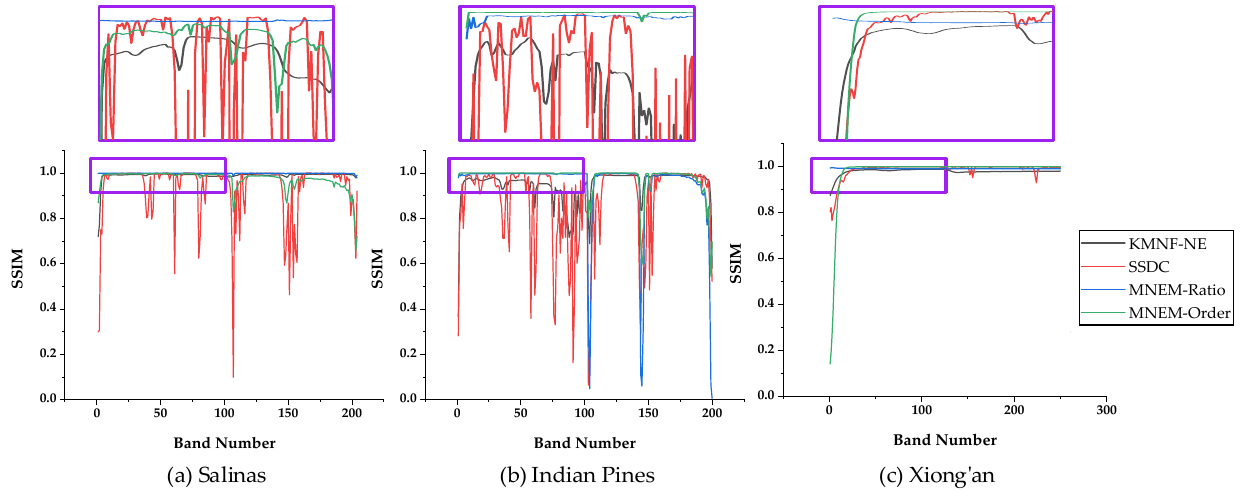
Figure 16. The structure similarity (SSIM) of each band on the ( a ) Salinas, ( b ) Indian Pines, and ( c ) Xiong’an datasets.